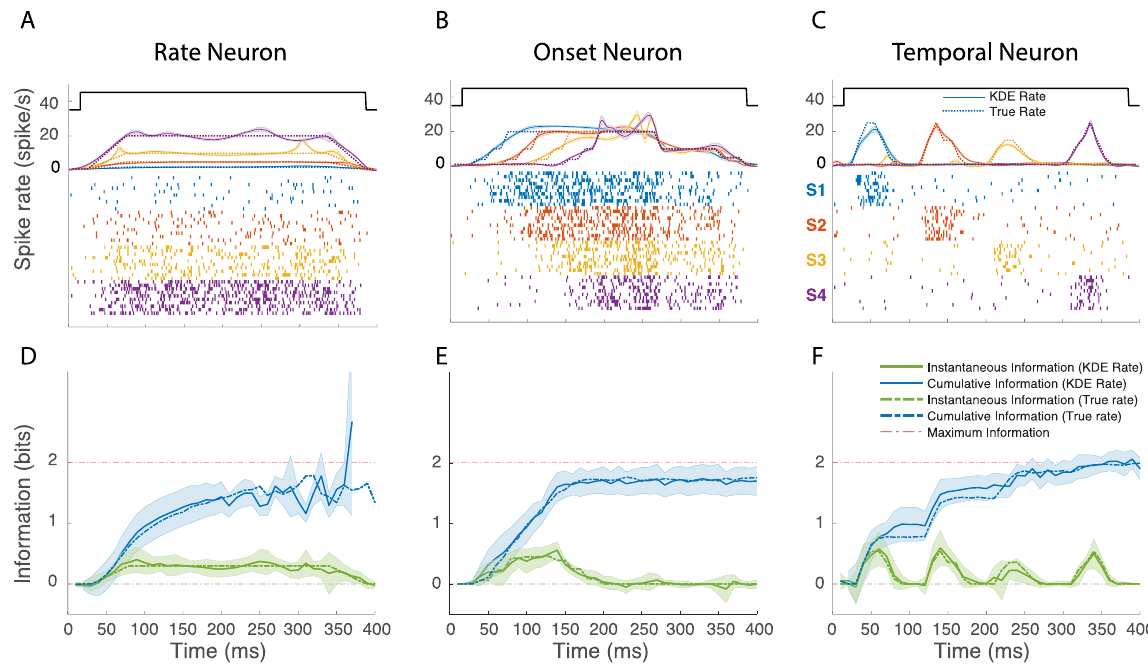
Fig 1. Instantaneous and cumulative information for 3 model poisson neurons. The top row ( A,B,C ) shows the firing rate and simulated spike rasters of 3 model neurons to 4 hypothetical stimuli (S1-S4). The onset and offset of all stimuli are identical and shown by the top solid black line. The model rates for the four stimuli are shown in colored dotted lines. These rates are used to generate spike patterns using an inhomogeneous Poisson process. Ten realizations for S1-S4 are shown as spike rasters. The rate recovered from those rasters using a time-varying kernel density estimate (KDE) are shown as colored solid lines. The shaded area around each line indicate the error on the KDE rate estimated by the standard error on the Jackknife estimates. The bottom row ( D,E,F )shows the instantaneous and cumulative information obtained using either the true model rate or the recovered rate from KDE. The error bars in the instantaneous information calculations were obtained by jackknifing the KDE estimates. For the cumulative information calculations, the Monte Carlo simulations were repeated for each jackknife estimate. The error bars therefore include both the errors in the estimation of the true rate from spike rasters (data limitation) and the errors in the estimation of the cumulative information due to limited sampling (computational limitation). The time-varying response rates were chosen to illustrate neural representation for stimuli using different neural codes labelled here as Rate ( A, D ), Onset ( B, E ), and Temporal ( C, F ).